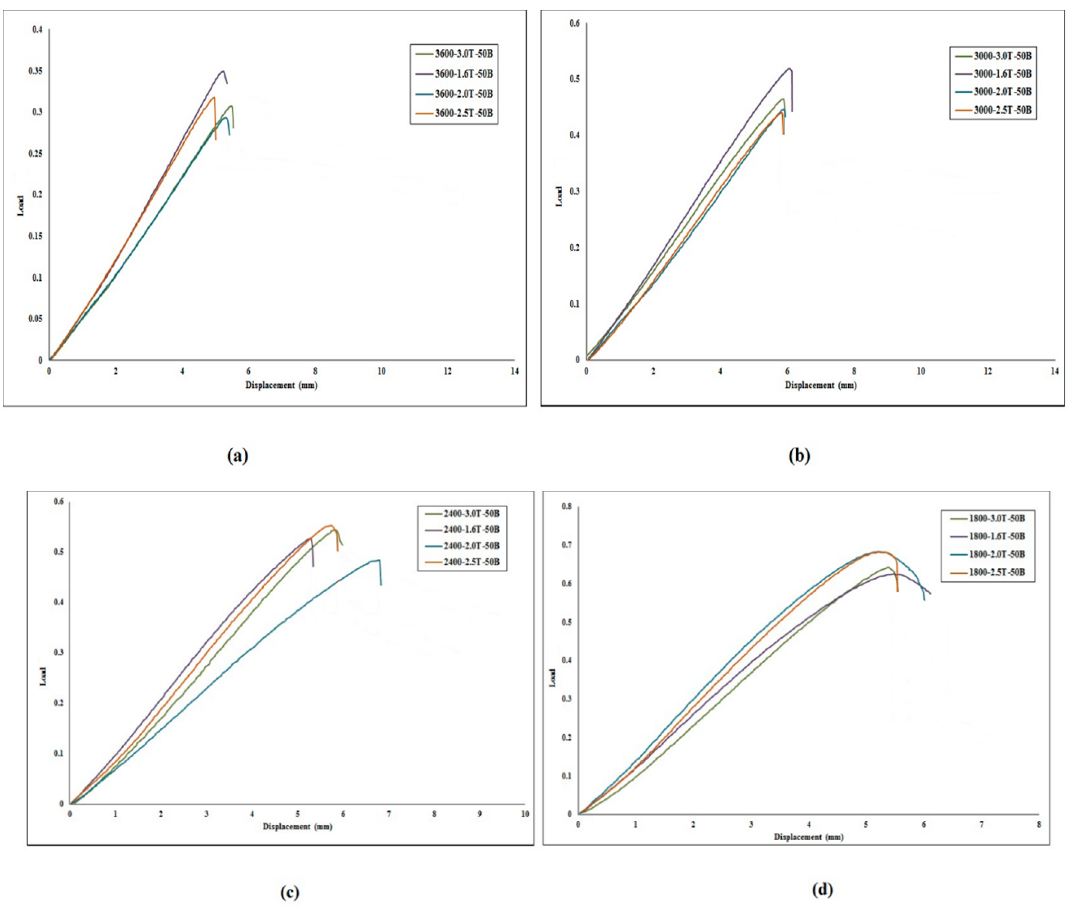
Figure 16. Normalised load-displacement diagrams of the FE results for: ( a ) 3600L-50B, ( b) 3000L-50B, ( c ) 2400L-50B, and ( d ) 1800L-50B models.